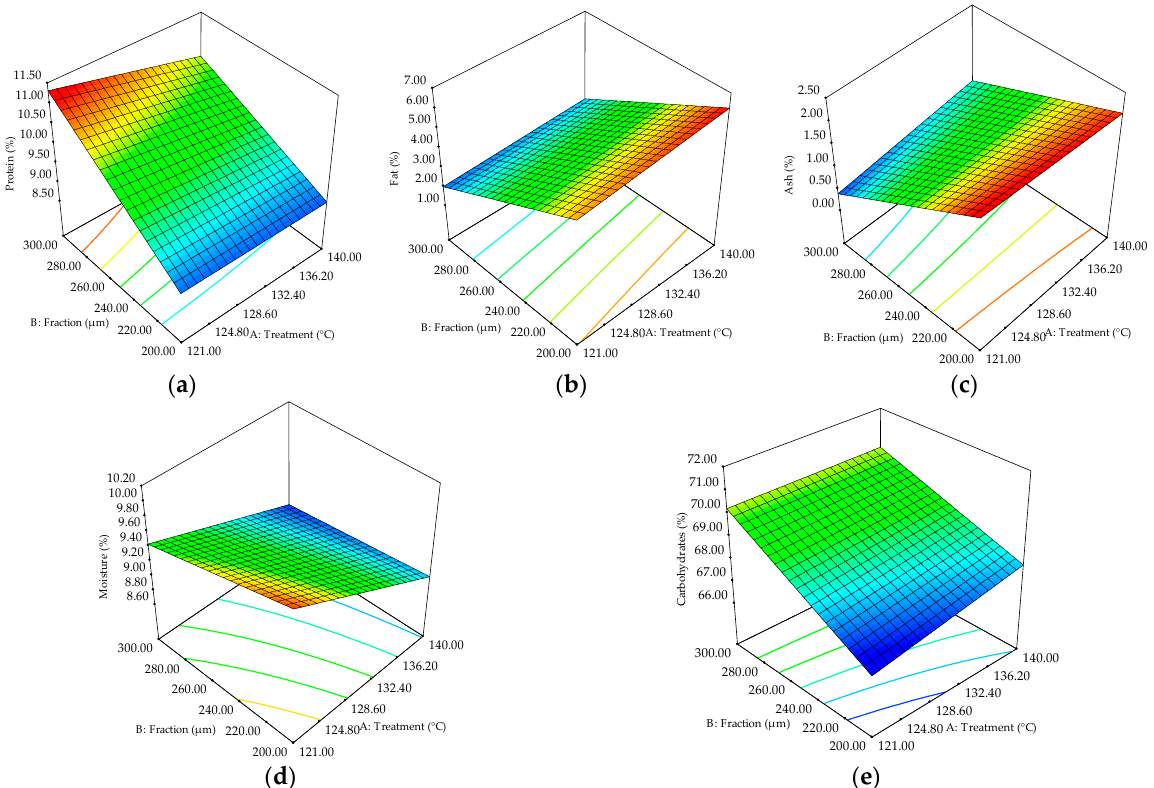
Figure 4. Three-dimensional graphic showing the combined effects of factors (treatment temperature and fractionation) on the sorghum flour content of: ( a ) protein, ( b ) fat, ( c ) ash, ( d ) moisture, and ( e ) carbohydrates.